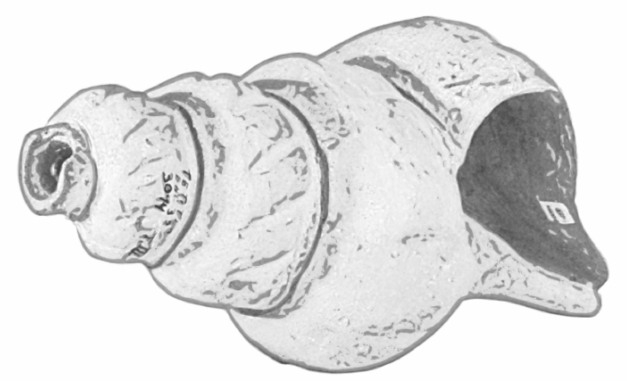
Figure 13. Ceramic horn at Burial 32, Tetitla, Teotihuacan (MNA, Inv. 10-223554), length: 28.3 cm.